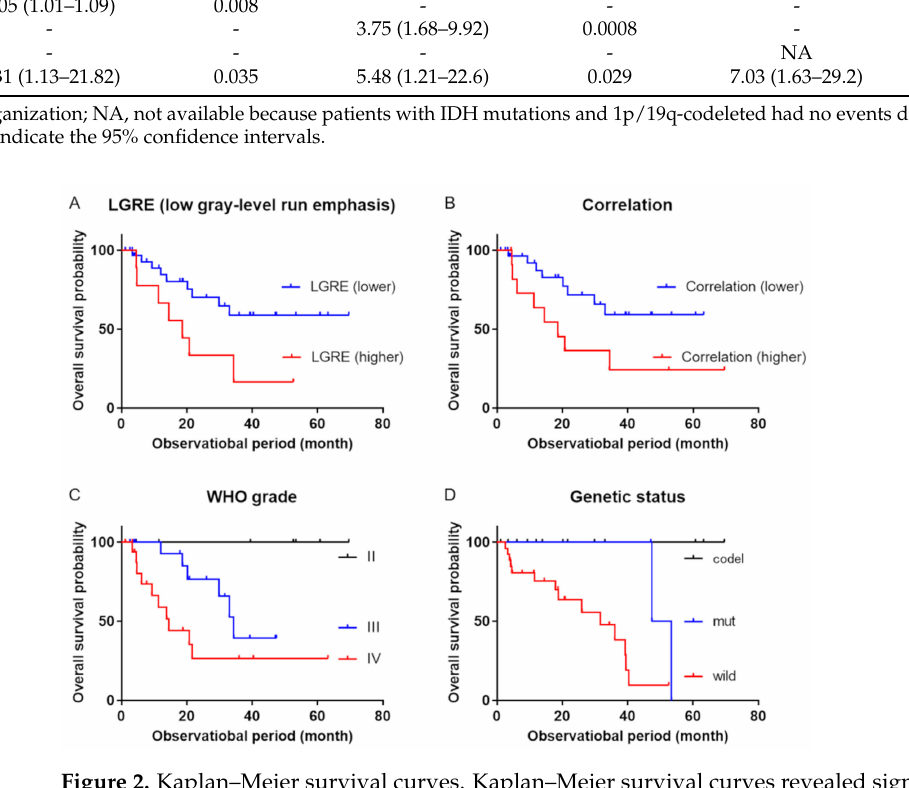
Figure 2. Kaplan–Meier survival curves. Kaplan–Meier survival curves revealed significant differ- ences in overall survival between ( A ) patients with low gray-level run emphasis (LGRE) of <0.088 (blue line) and >0.088 (red line) ( p = 0.022), ( B ) patients with correlation values of <1.074 (blue line) and >1.074 (red line), ( C ) patients with the different WHO grades (black line = grade II, blue line = grade III, red line = grade IV; p = 0.0066), and ( D ) patients with the different genetic statuses (black line = IDH mutant with 1p/19q-codeleted, blue line = IDH mutant without 1p/19q-codeleted, red line = IDH wild-type without 1p/19q-codeleted, p = 0.0004). WHO: World Health Organization; IDH: isocitrate